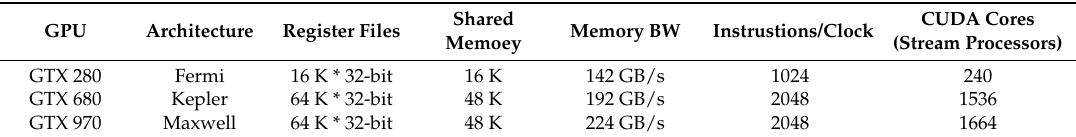
Table 2. Resource distribution of different